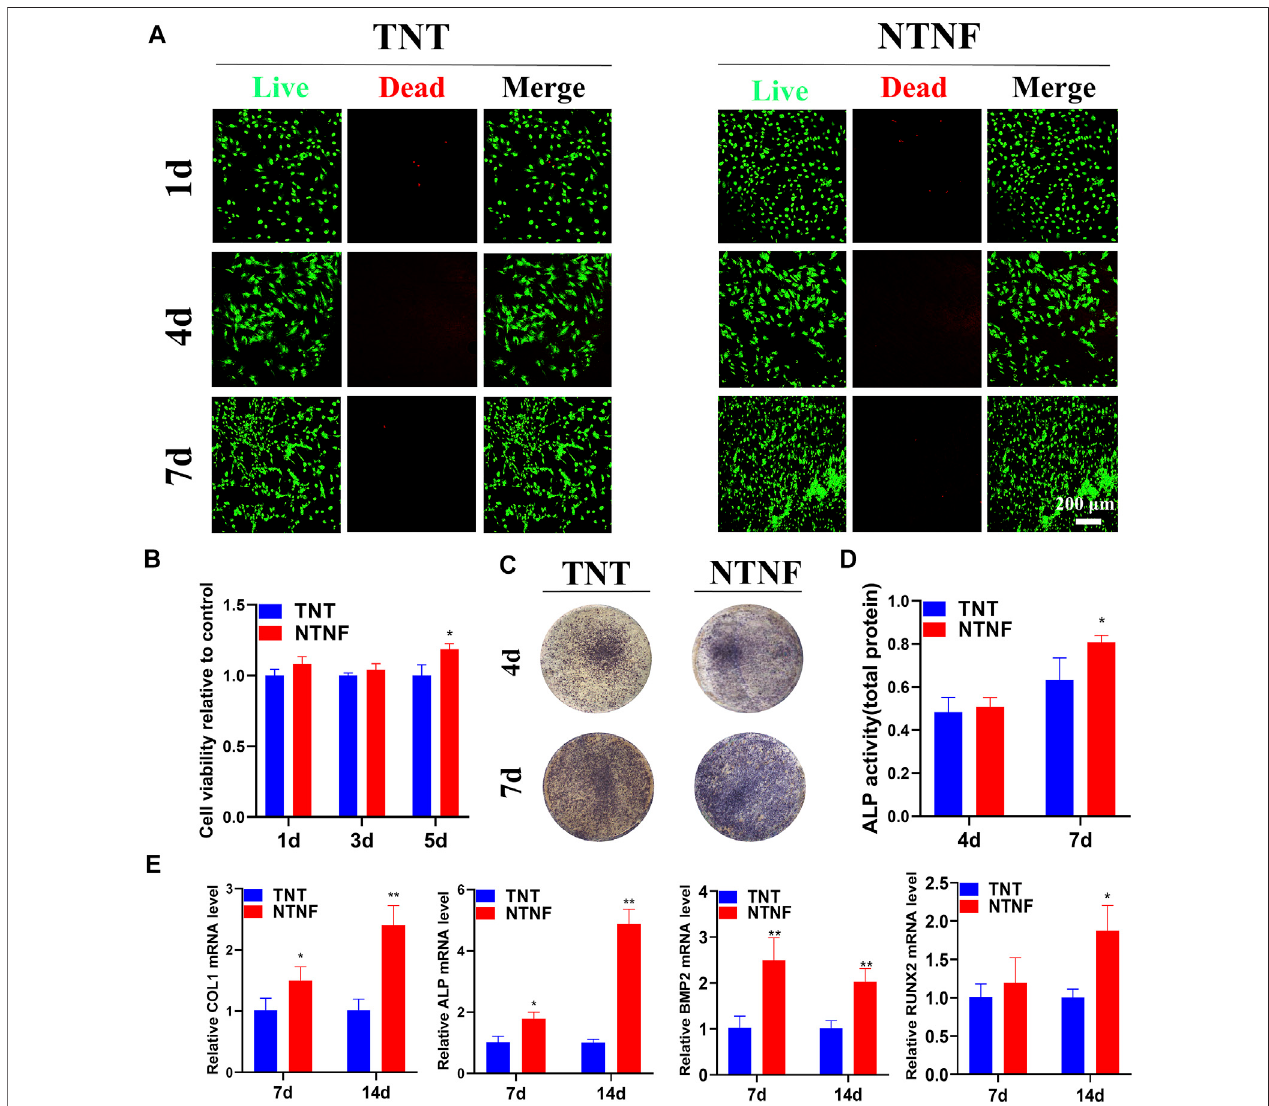
FIGURE 7 | (A) Live/dead (SYTO 9/PI) staining images of rBMSCs cultured on the surface of TNT and NTNF for 1, 4, and 7 days. (B) Cell counting kit-8 (CCK-8) assay of rBMSCs cultured on TNT and NTNF. (C) Alkaline phosphatase (ALP) staining and (D) activity images of rBMSCs in the different groups after 4 and 7 days. (E) Expression of osteogenesis-related genes analyzed by RT-qPCR in rBMSCs cultured on different samples for 7 and 14 days. * p < 0.05, ** p < 0.01 compared with the TNT group.